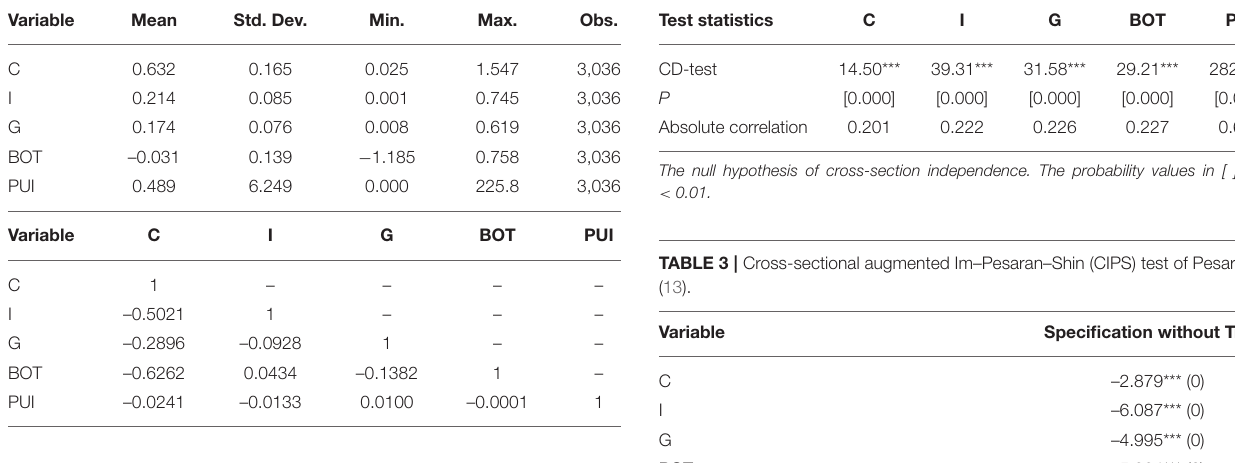
TABLE 2 | Cross-sectional dependence (CD) Test of Pesaran (2004 and 2015). Test statistics